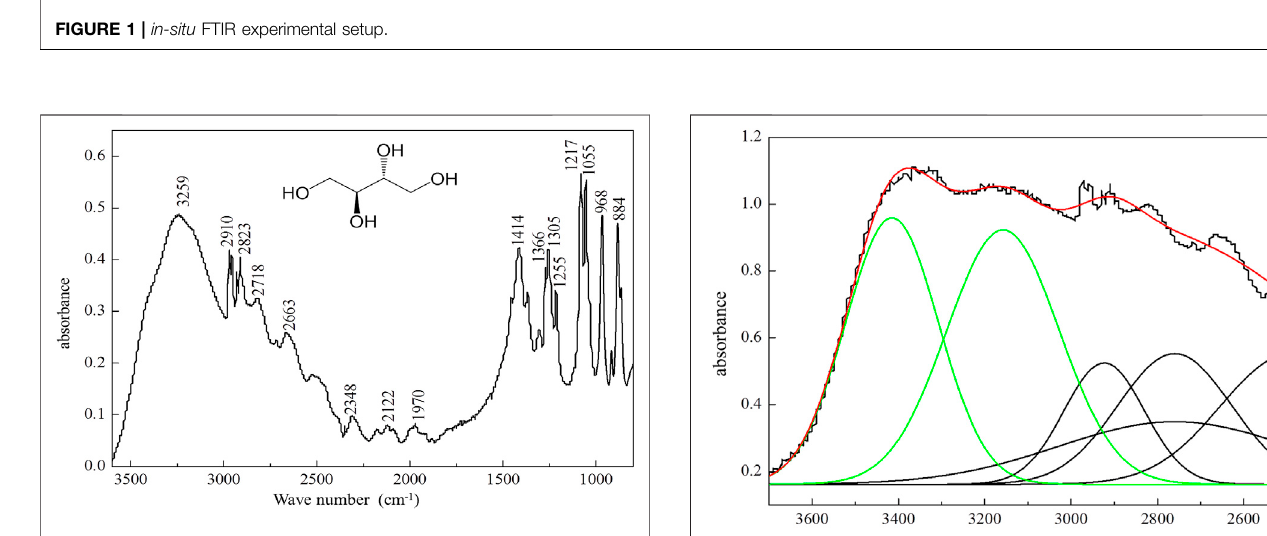
FIGURE 2 | Infrared spectrum of AME at room temperature.